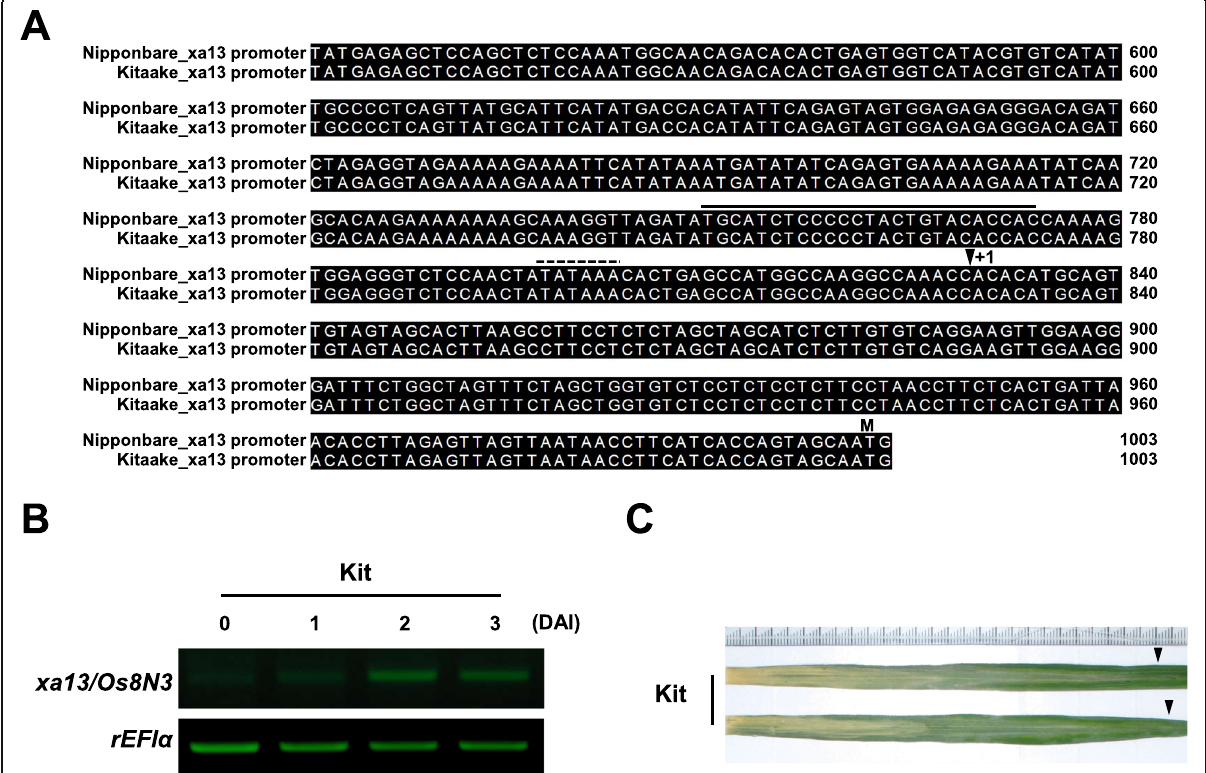
Fig. 1 Os8N3 is a susceptibility gene for Xoo strain PXO99 in rice cultivar Kitaake. a Promoters containing a PthXo1 EBE (upper line) from Nipponbare and Kitaake displayed 100% identity to each other. The putative TATA box is shown by a dashed line. The transcription start site is represented by a vertical arrowhead noted as + 1. The translational initiating ATG codon is shown as ‘ M ’ . b Expression of Os8N3 is elevated after inoculation with Xoo strain PXO99 in Kitaake. Rice elongation factor 1 α ( rEF1 α ) was used as an internal control. c Kitaake exhibited a susceptible phenotype with long water-soaked lesions after inoculation with PXO99. The lesions were photographed 12 days after inoculation (DAI) and arrowheads indicated the end of the